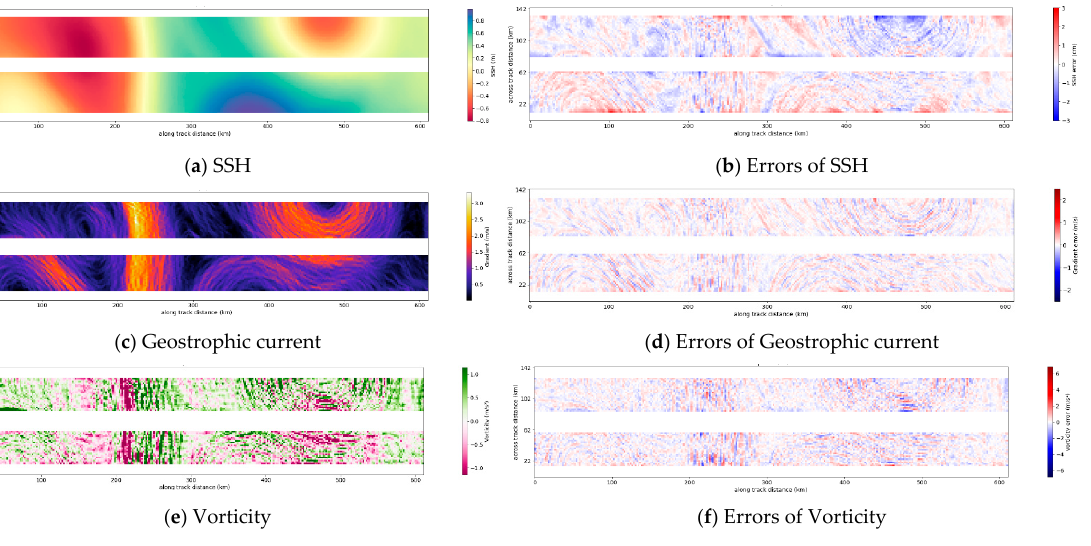
Figure A1. SSH denoised by the Median smoother and its derivatives in the left column. The associated errors are plo tt ed in the right columns. The ground truth of the SSH, the geostrophic current and the vorticity are in Figures 3–5, respectively (Pass 496, cycle 17 located in the Gulf Stream).